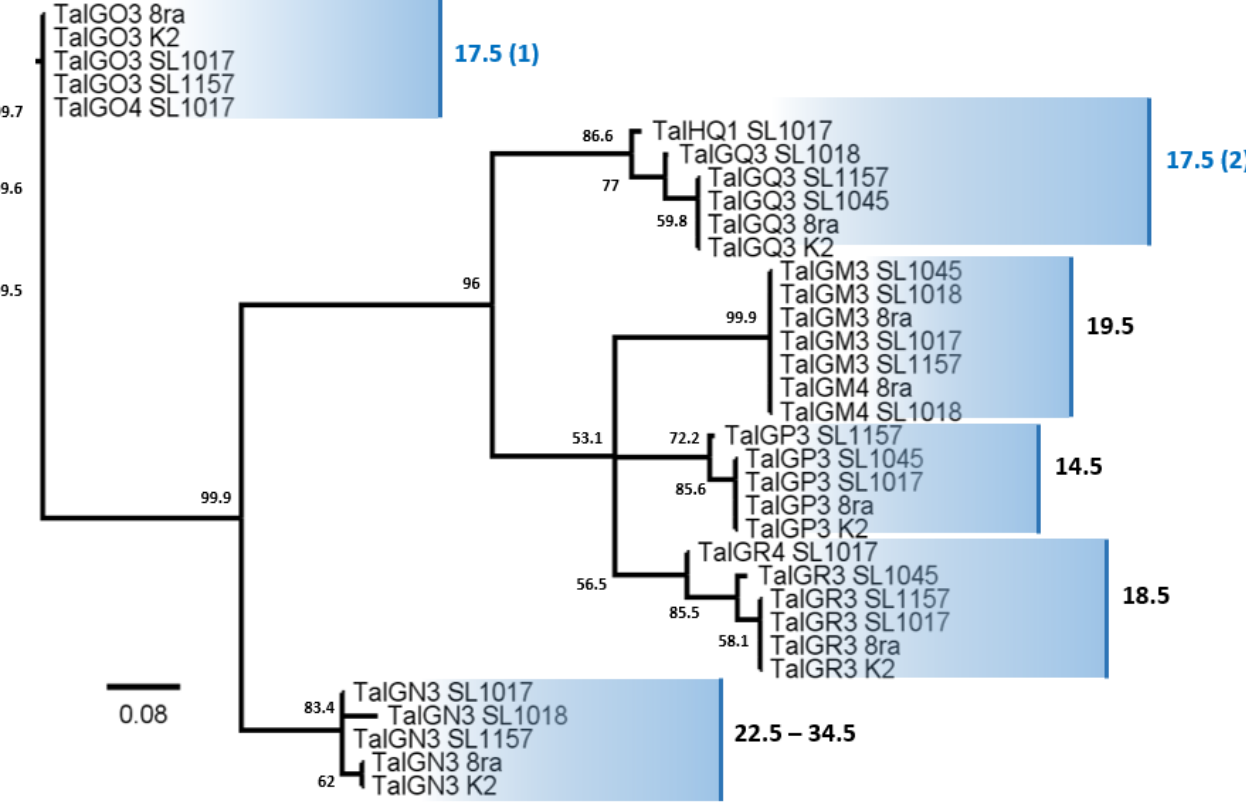
Figure 8. Phylogenetic tree of the transcription activator-like effectors identified in six X. citri pv. glycines strains based on their repeat variable di-residue sequences. The Neighbor-Joining tree was based on bootstrapping of 1000 replications. Bootstrap values above 50% are shown on the node. Bar (0.08) indicates the substitution rate per nucleotide position.